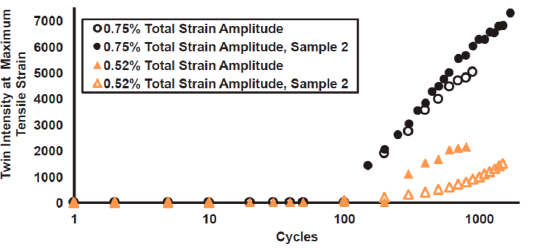
Figure 32. The variation of twin intensity at maximum tensile strain versus the number of cycles in the case of cyclic loadings with the strain amplitude of 0.75% and 0.52% (After Murphy ‐ Leonard et al. [7]).